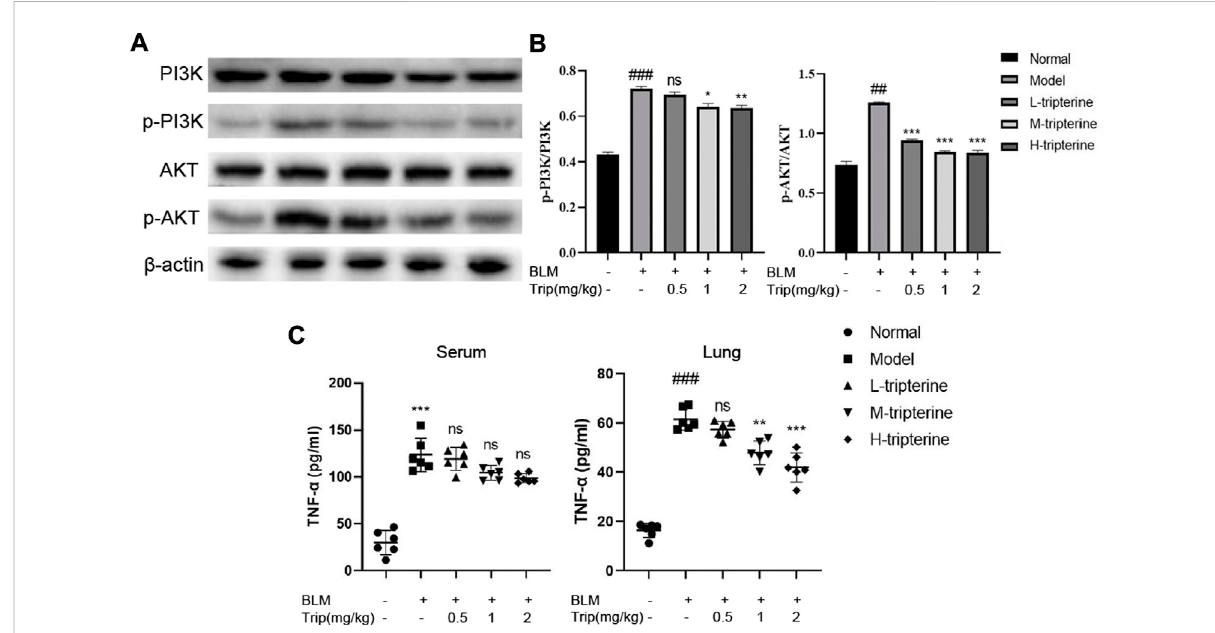
FIGURE 8 Effects of tripterine on phosphatidylinositol-3-kinase (PI3K)/protein kinase B (Akt) and tumour necrosis factor (TNF)- α expression levels. (A) PI3K/Akt-relatedproteinexpressioninlungtissueswasdetectedbyWesternblotting. (B) DensitometryanalysisofPI3K/Aktproteinexpression.Scale bars:50 μ m.Dataarepresentedasthemean±standarddeviation(SD), n =3. (C) TNF- α expressioninthelunghomogenateandserum ofmicewere detected by enzyme-linked immunosorbent assay. Data are presented as the mean ± SD, n = 6. ### p < 0.001 vs. the normal group; * p < 0.05, ** p < 0.01, and *** p < 0.001 vs. the BLM-treated group. BLM, bleomycin (5 mg/kg); Trip, tripterine.